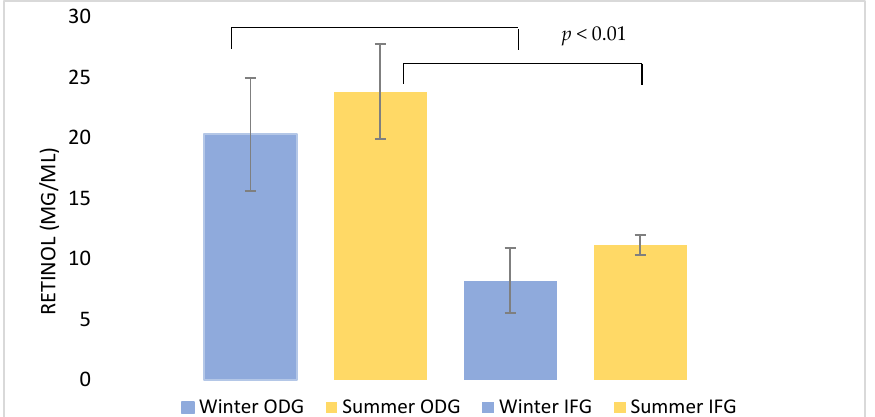
Figure 4. Retinol concentrations in milk during the winter and summer seasons between the two different farming systems. Data are reported as mean (µg/mL) ± S.D. of the total retinol concentration in each sample. p < 0.01. ODG: Outdoor grazing, IFG: intensive feeding.